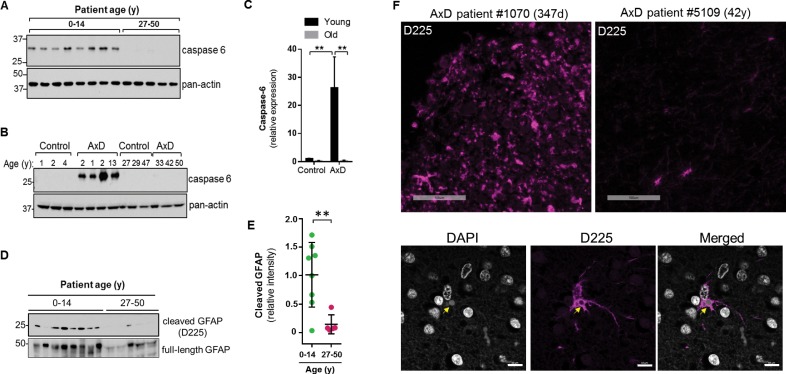
High expression of caspase-6 in young AxD patient brain tissue correlates with increased levels of cleaved GFAP.(A) Immunoblot for caspase-6 in total lysates from human AxD post mortem brain tissue shows that caspase-6 is upregulated in young AxD patients. Pan-actin is used as a loading control. (B) Immunoblot for caspase-6 in total lysates from young and old non-AxD control and AxD patient post-mortem brain tissue. Pan-actin blot serves as a loading control. (C) Quantification of band intensities in panel B by densitometry of caspase-6 normalized to actin. **p<0.01; two-way ANOVA. (D) Western blotting for full-length GFAP or cleaved GFAP (D225 antibody) in HSEs from human AxD post-mortem brain tissue. (E) Quantification of band intensities from panel D by densitometry of D225, normalized to total GFAP (**p<0.01, unpaired t-test). (F) Immunofluorescence staining showing widespread presence of cleaved GFAP (D225; magenta) in cerebral cortex and underlying white matter of 347 day-old child with AxD and low expression of cleaved GFAP in a 42 year old AxD patient. Wider fields of view and sections from additional patients are shown in Figure 7—figure supplement 1. DAPI nuclei are shown in white in bottom panels, and arrow highlights perinuclear aggregate containing cleaved GFAP and staining positively for DAPI in brain tissue from a child with AxD. Scale bar = 100 µm (top) and 10 µm (bottom).